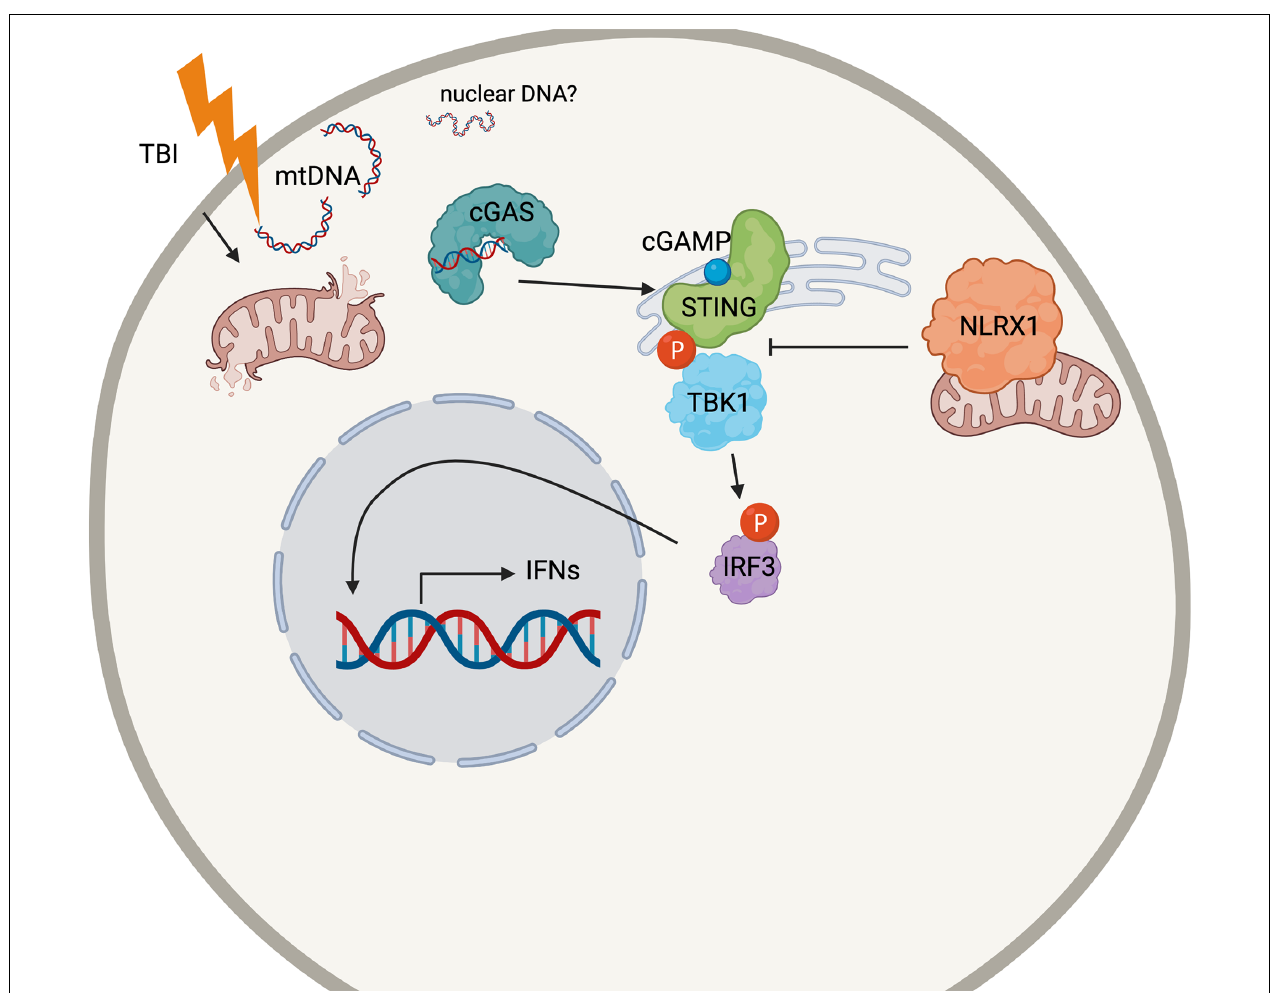
FIGURE 7 | Schematic cartoon of the proposed mechanism. Following TBI, mitochondria release DNA (mtDNA) into the cytoplasm which may bind cGAS to prompt STING activation. STING is phosphorylated by TBK1, which also phosphorylates the transcription factor IRF3. Nuclear translation of IRF4 causes the production of the Type I interferon response in the injured brain. NLRX1 may sequester STING to block its phosphorylation by TBK1. The figure was made with